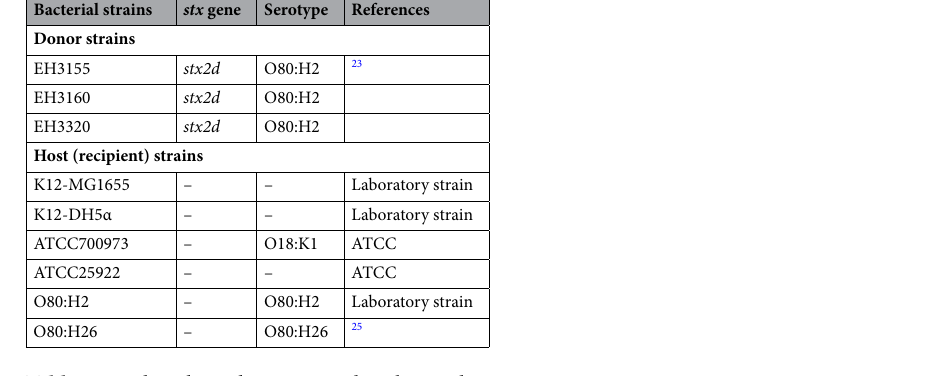
Table 1. Escherichia coli strains used in this